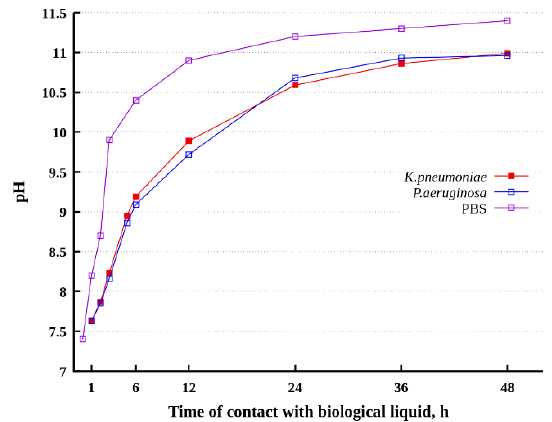
Figure 6. Variation in pH with duration of contact between the MA8 alloy sample with the superhydrophobic coating and PBS with or without bacterial cells.